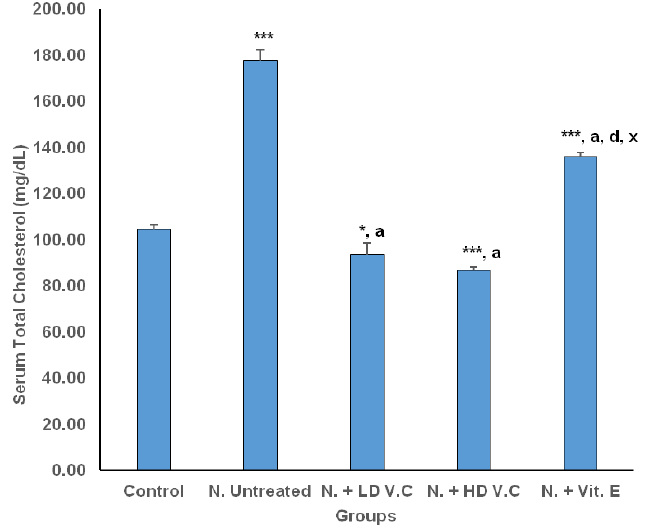
Figure 1. Effect of V. calvoana extract on serum total cholesterol in paracetamol-treated rats. Values are presented as mean ± SEM, n = 5. * p < 0.05, *** p < 0.001 vs. control, a = p < 0.001 vs. N. untreated, d = p < 0.001 vs. N + LD VC, x = p < 0.001 vs. N + HD VC. Where N = hepatotoxic.